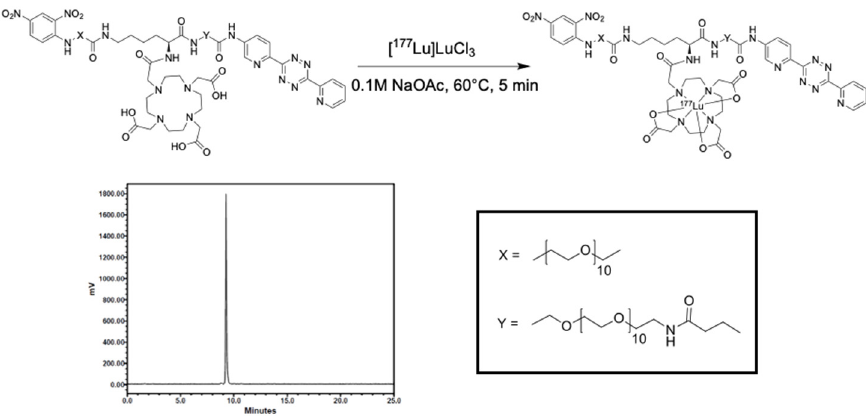
Figure 3. Radiolabeling scheme and radio-HPLC chromatogram of the tetrazine small molecule labeled with lutetium-177.